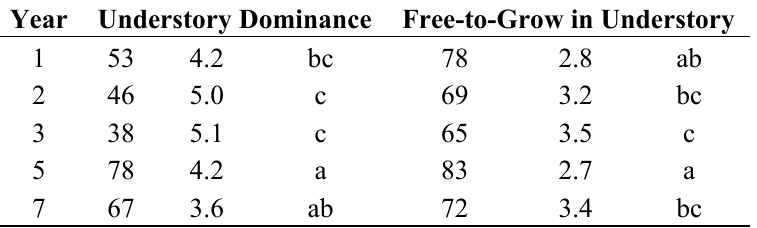
Table 5. Least-squares means and associated standard errors for percent of trees dominant and free-to-grow in the understory canopy layer for northern red oak seedlings planted in a shelterwood harvest. Means followed by the same letters are not significantly